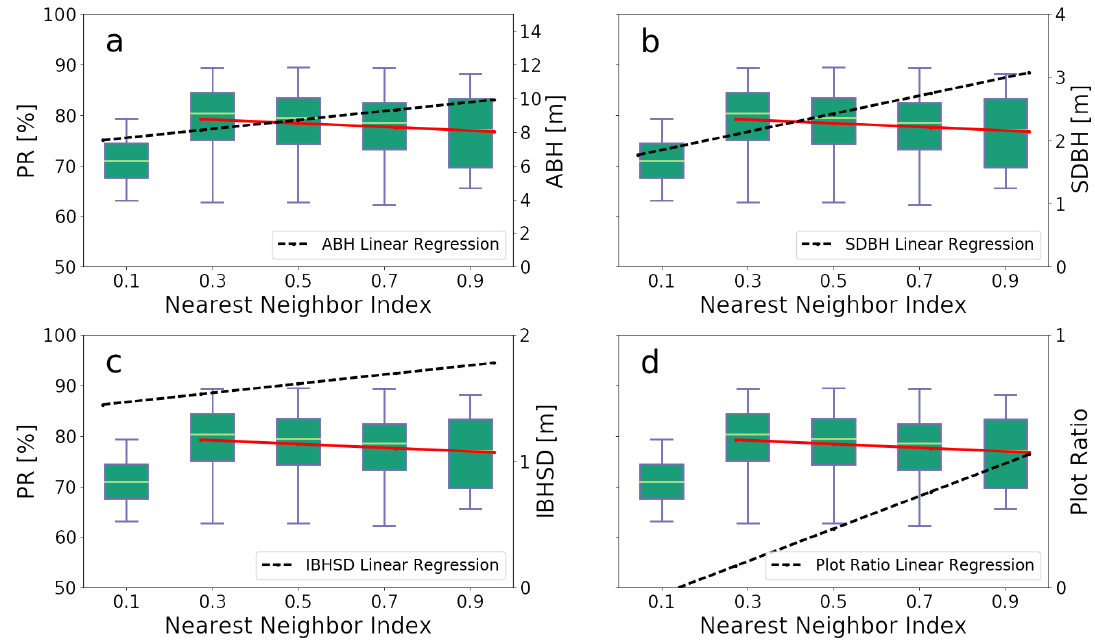
Figure 9. PR compared with the nearest index